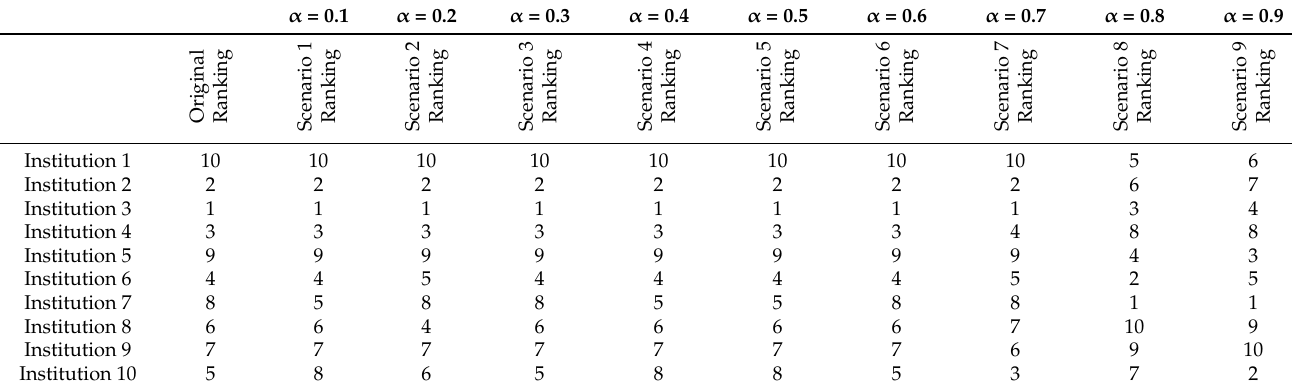
Table 7. Sensitive